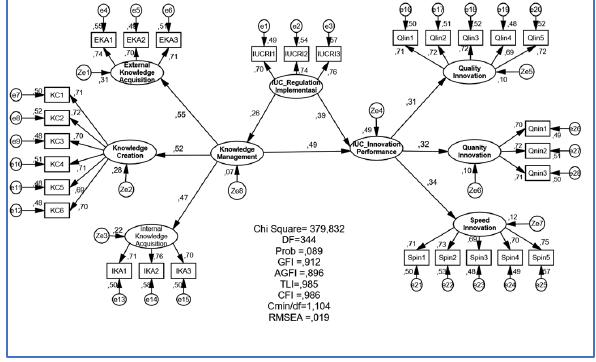
Fig. 4. Results of full structural model